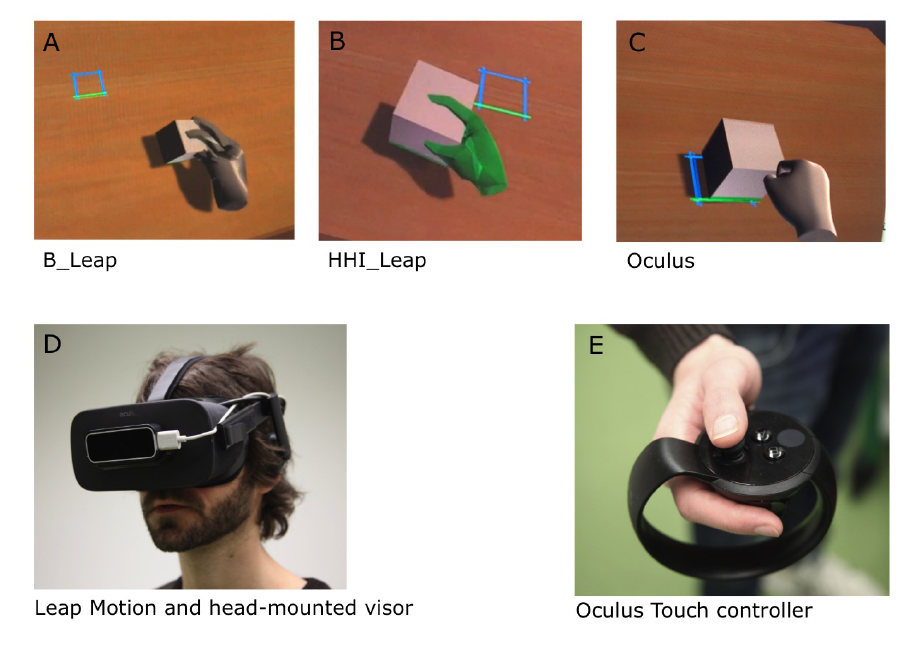
Figure 2. Virtual representations of the hands for ( A ) basic Leap Motion (B_Leap), ( B ) modified Leap Motion (HHI_Leap), and ( C ) Oculus Touch handheld controller (Oculus); ( D ) mounted Leap Motion sensor; ( E ) Oculus Touch handheld